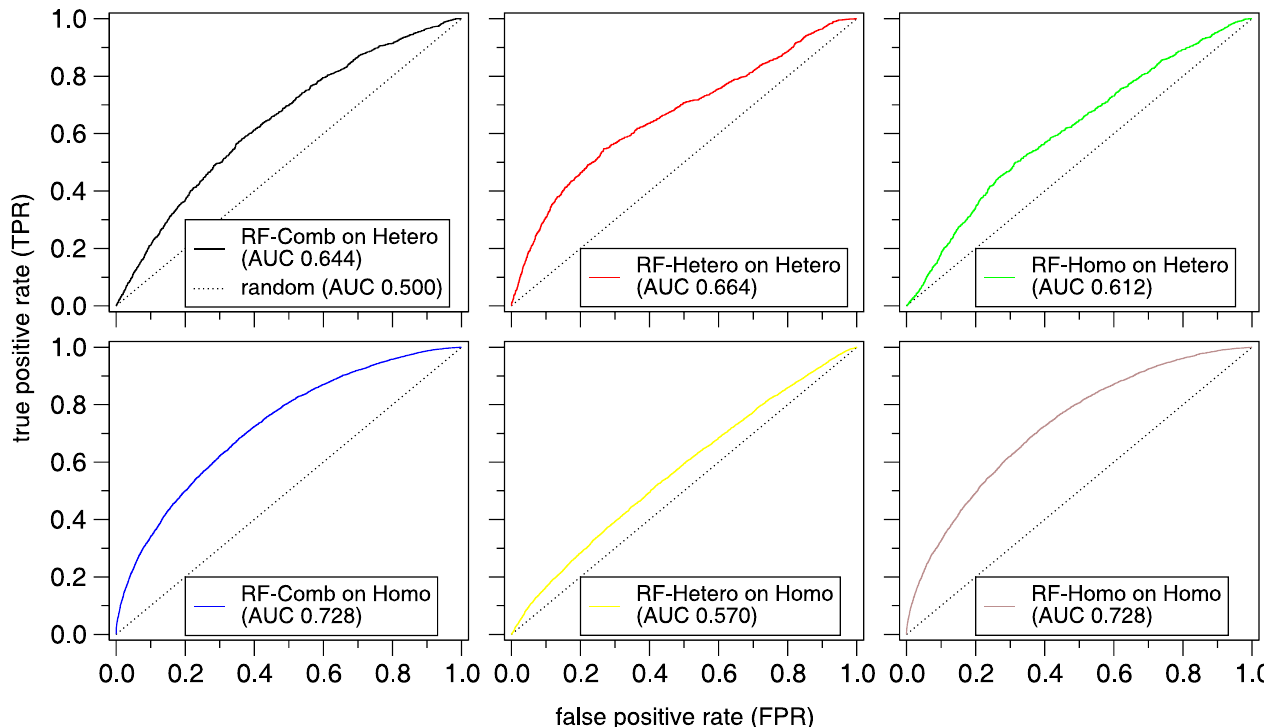
Fig 6. “ROC plots showing the performance of Models RF-Comb, RF-Hetero, and RF-Homo, trained on the combined, heteromeric, and homomeric training sets, respectively, and tested on the heteromeric and homomeric test sets”. When you evaluate several models on different test sets, you should clearly indicate which test set was used for which model followed by the relevant scores. Moreover, if the model names do not readily indicate which training set they were derived from, you should include this in the caption. Created with data from Hou and colleagues [19].